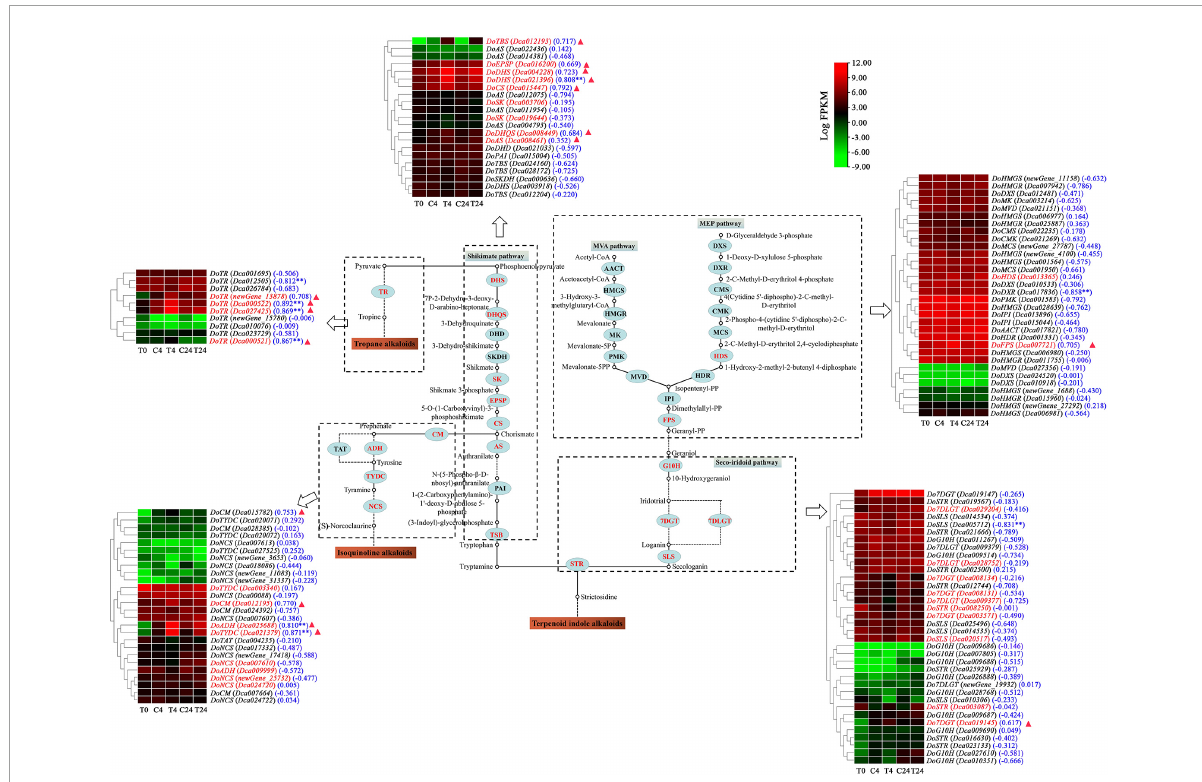
FIGURE7 Expression patterns of genes putatively involved in the biosynthesis of alkaloids in D. officinale PLBs under precursor and MeJA treatment. The enzymes are marked in red, indicating that genes encoding the enzymes showed different expressions in the C4 vs. T4 or C24 vs. T24 groups. The genes marked in red in the heat map indicates the DEGs identified from the C4 vs. T4 or C24 vs. T24 groups. Blue numbers in brackets represent the correlation coefficient which analyzed between alkaloid content and biosynthesis-related genes. ∗∗ p < 0.01 and | r | > 0.8. The red triangle indicates that the gene was found in the brown